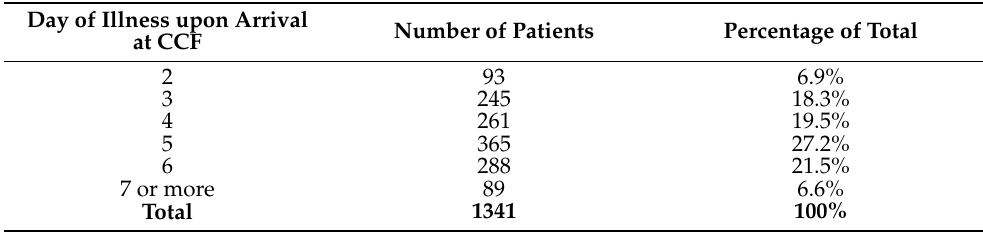
Table 3. Number of patients admitted to the CCF/CRF@Big Box from 4 July 2020 to 2 Aug 2020 based on their day of illness upon arrival to the